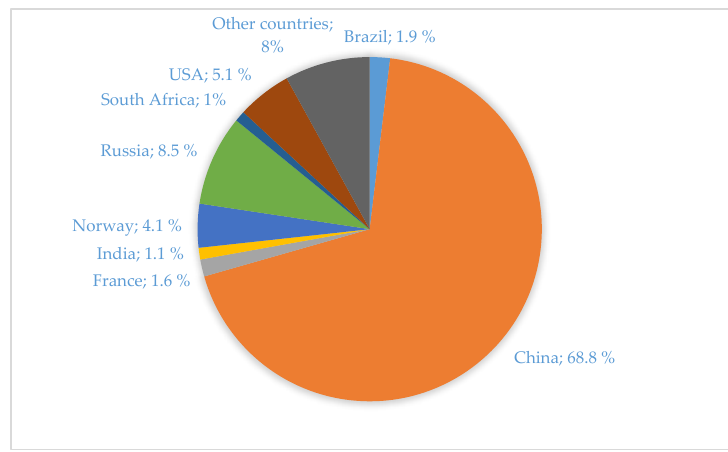
Figure 4. The share of leading countries in the production of the world’s silicon supply. Source: based on data [48].